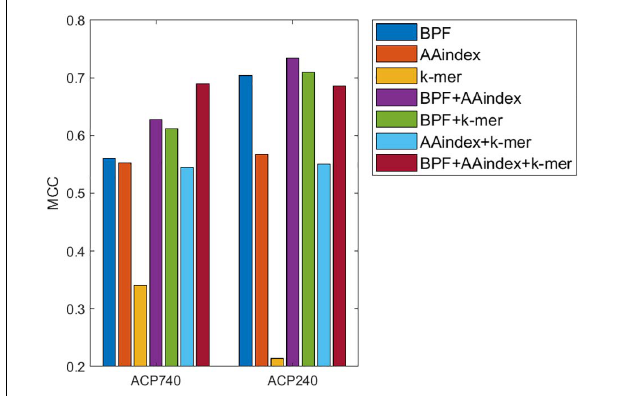
FIGURE 3 | Comparison of prediction models using BPFs, the AAindex, the k-mer sparse matrix (k-mer), and their concatenations based on ACP740 and